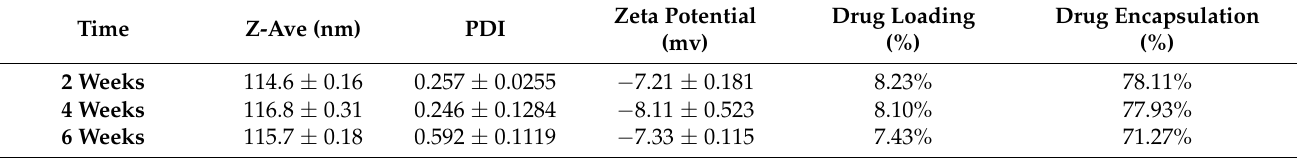
Table 1. Stability of BS − LipoIRI (1:100) after 2, 4, and 6 weeks of storage. The average particle size, PDI, and zeta potential are expressed as mean ± SE of three independent